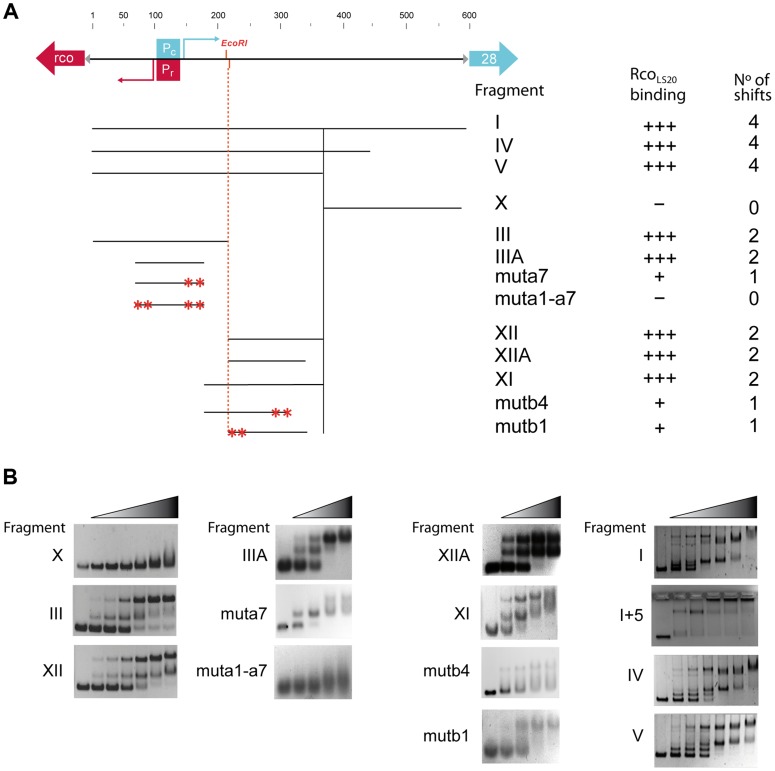
Analysis of the RcoLS20 binding sites in the rcoLS20 - gene 28 intergenic region by EMSA.
A. Schematic representation of the DNA fragments used as probes and a summary of the EMSA results. Top panel. A map of the 600 bp rcoLS20-gene 28 intergenic region is shown as a black line alongside with the positions of the characteristics in this region. The divergently oriented genes rcoLS20 and 28 are indicated with a red and blue arrow, respectively. The triangles indicate ribosomal binding sites. The position of the Pc and the Pr promoter (boxed) and their transcription start sites (bent arrows) are indicated in blue and red, respectively. The position of the unique EcoRI site in this region is also indicated. Lower panel shows the different fragments used in EMSA; the names of the DNA fragments, the levels of RcoLS20 binding and the numbers of shifts are indicated on the right. Asterisks indicate positions of introduced mutations. B. Examples of the EMSA results obtained using DNA fragments described in panel A. The left-most lane of each panel corresponds to samples loaded without protein. Increasing concentrations of RcoLS20 were prepared using a two-fold dilution method, and ranged from 0.212–6.8 (7 lane panels) or 0.95–7.3 µM (5 lane panels).